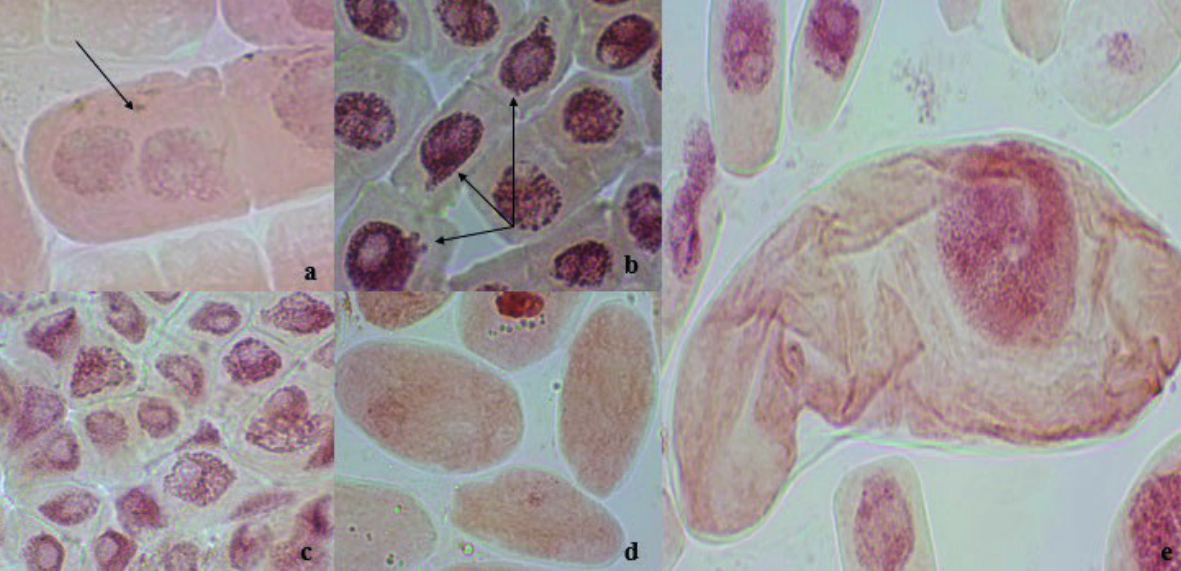
Figure 15. Nuclear aberrations found in A. cepa root tip meristematic cells following treatments with simple extracts and with extracts sup- plemented with MNPs (a – Binucleate cells in M_MAE_10_70; b – Nuclei buds in M_M_50_AgCl; c – Irregularly shaped nuclei in H2Od; d – Ghost cells in M_M_50_AgCl; e – Giant cell in